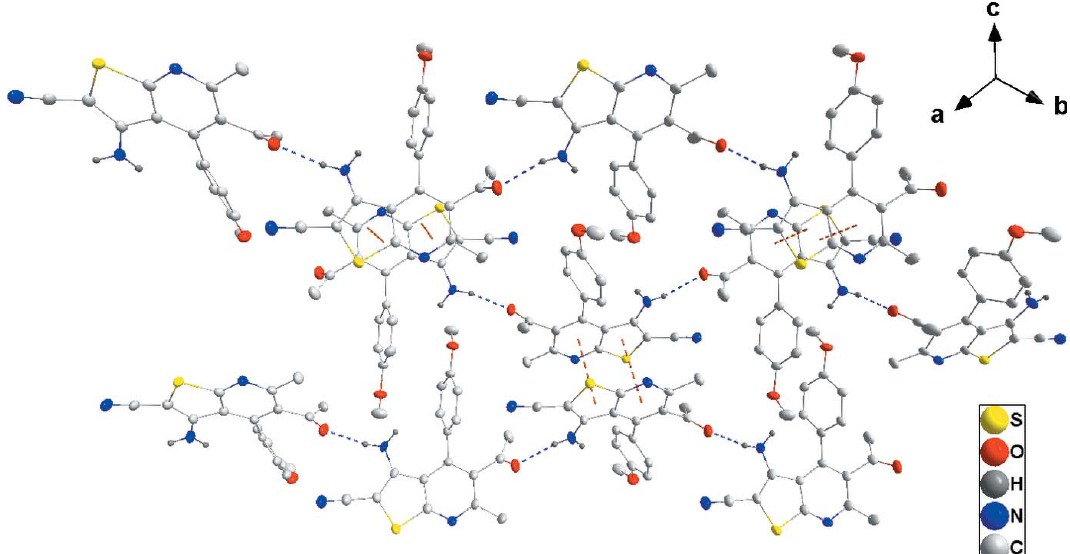
Figure 2 A portion of the packing projected onto (111). The N—H (cid:2)(cid:2)(cid:2) O hydrogen bonds and the (cid:2) -stacking interactions are shown, respectively, as blue and orange dashed lines.